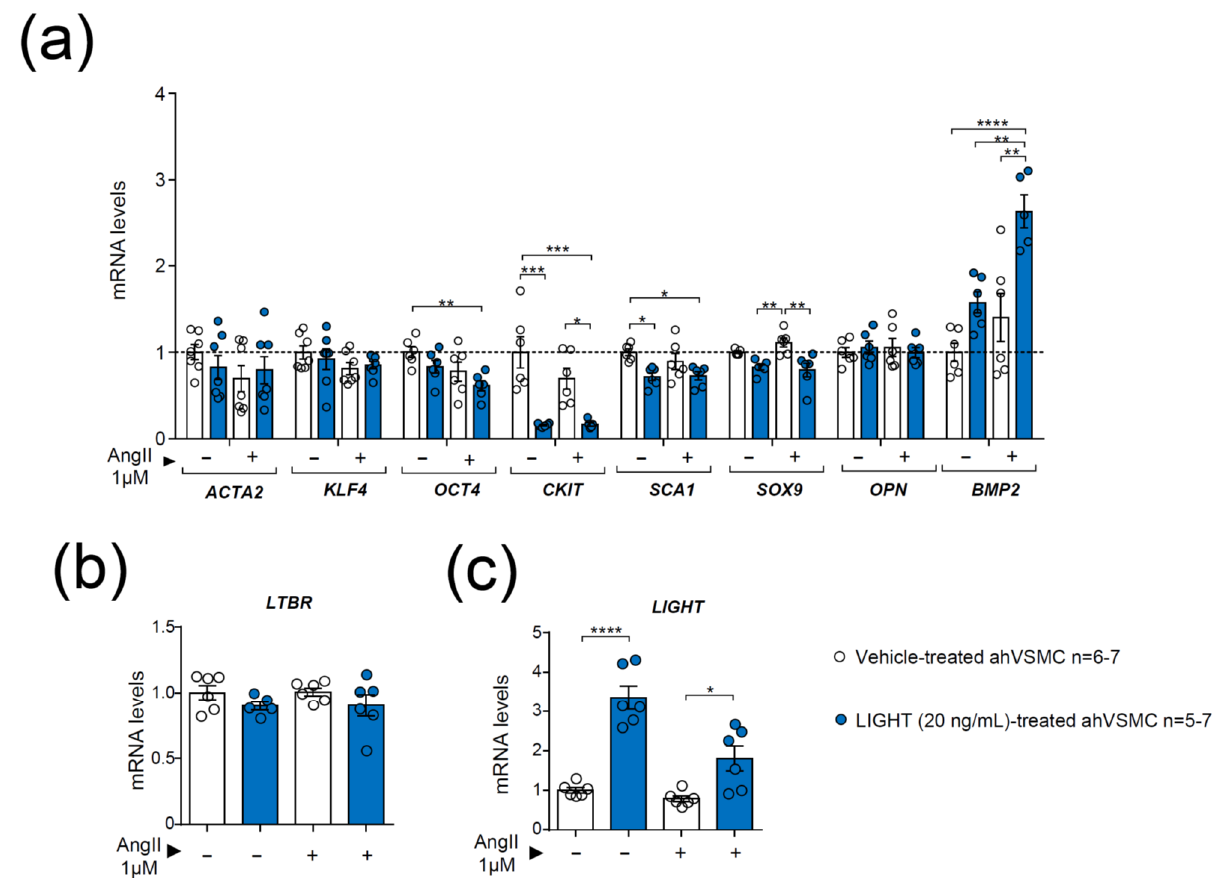
Figure 6. Impact of AngII in the gene expression of vehicle or LIGHT-treated aortic human VSMCs (ahVSMCs). Expression of ( a ) ACTA2, KLF4, OCT4, CKIT, SCA1, SOX9, OPN , and BMP2 mRNA levels in ahVMSCs treated overnight as indicated. mRNA levels of the human ( b ) LTBR , ( c ) LIGHT genes in ahVSMCs stimulated overnight as indicated. mRNA levels were normalized to GAPDH mRNA levels and relativized to vehicle-treated ahVMCs. Data are mean ± SEM. Statistical analysis was performed using two-way ANOVA followed by Tukey’s multiple comparison test. * p ≤ 0.05, ** p < 0.01, *** p < 0.001 and **** p < 0.0001.